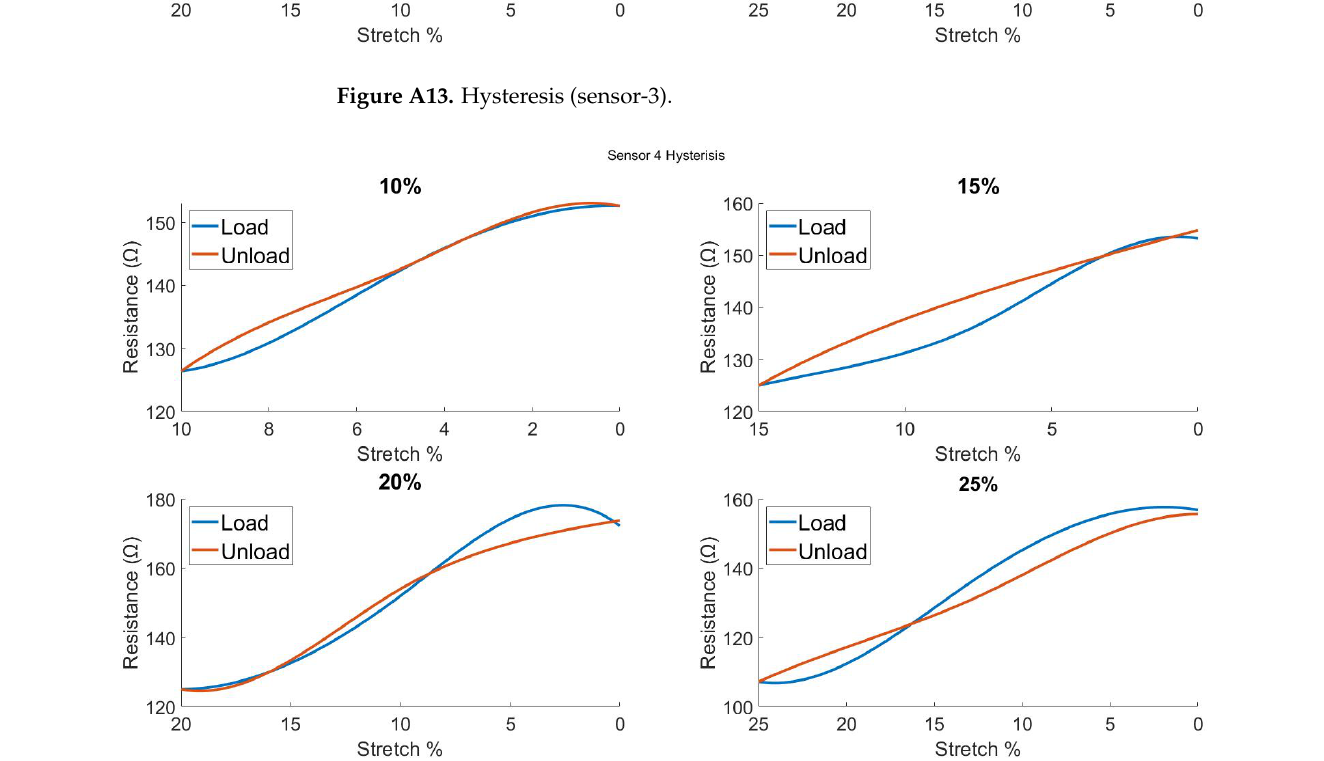
Figure A14. Hysteresis